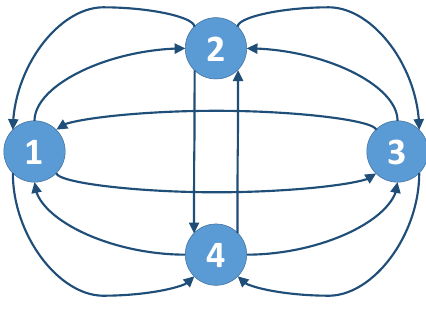
Figure 4. Directed complete graph with four